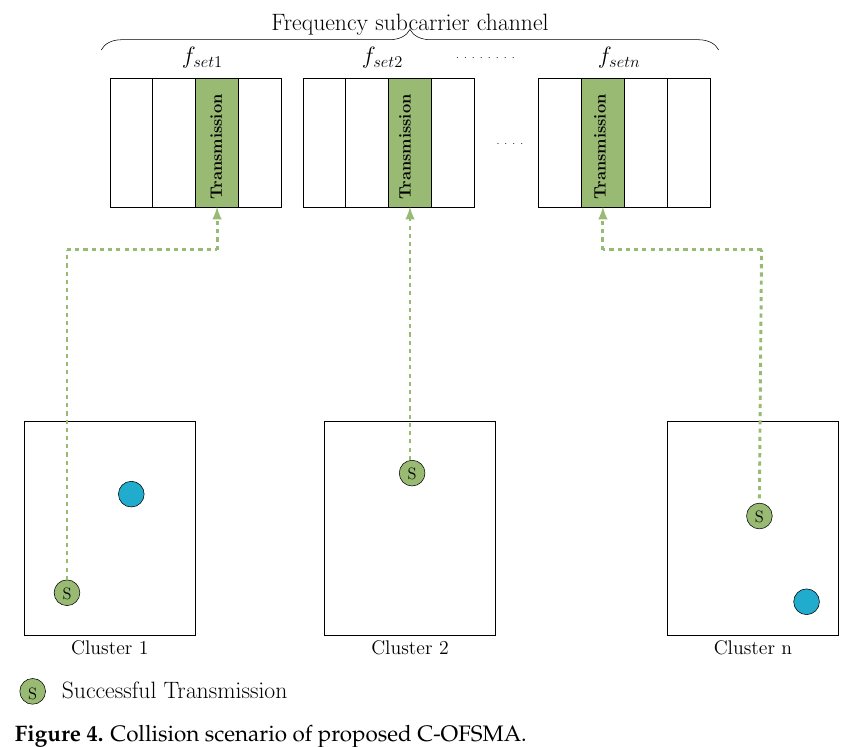
Figure 4. Collision scenario of proposed C-OFSMA.